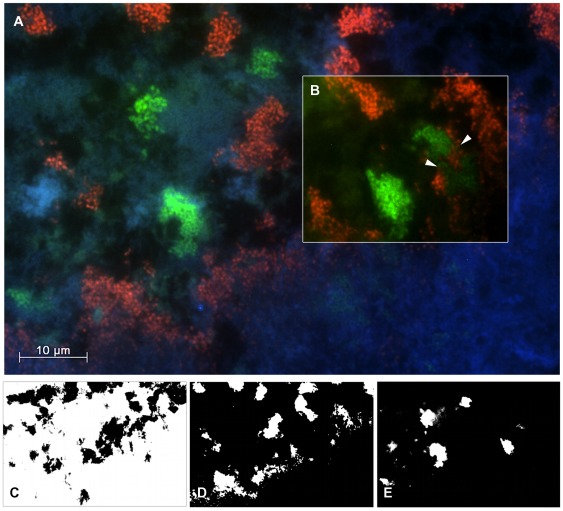
Visualization of the spatial arrangement of P. gingivalis and P. intermedia.FISH analysis performed on a carrier of GAP patient 05 reveals P. gingivalis in combination with P. intermedia respectively detected by the probes POGI-Cy5 (green) and PRIN-Cy3 (red). The domain-specific probe EUB338-FITC (blue) displays the entire biofilm expanded between the gingival surface at the bottom of the image and the carrier surface at the top. (A) An overlay of Cy3, Cy5 and FITC channels shows discrete microcolonies of P. gingivalis and P. intermedia apparently equispaced except the part marked by arrowheads. (B) In a punctual area species-specific channels Cy3 and Cy5 reveal both bacteria closely intermingled. (C–E) shows the respective binary masks of the micrograph (A) prepared for statistical quantification of the spatial relationship. (C) The EUB338-FITC-channel served as reference mask to limit the calculation to the area of the biomass. (D–E) Between the segmented masks of species-specific channels PRIN-Cy3 (red) and (E) POGI-Cy5 (green) daime calculated the pair cross correlation function g(r).